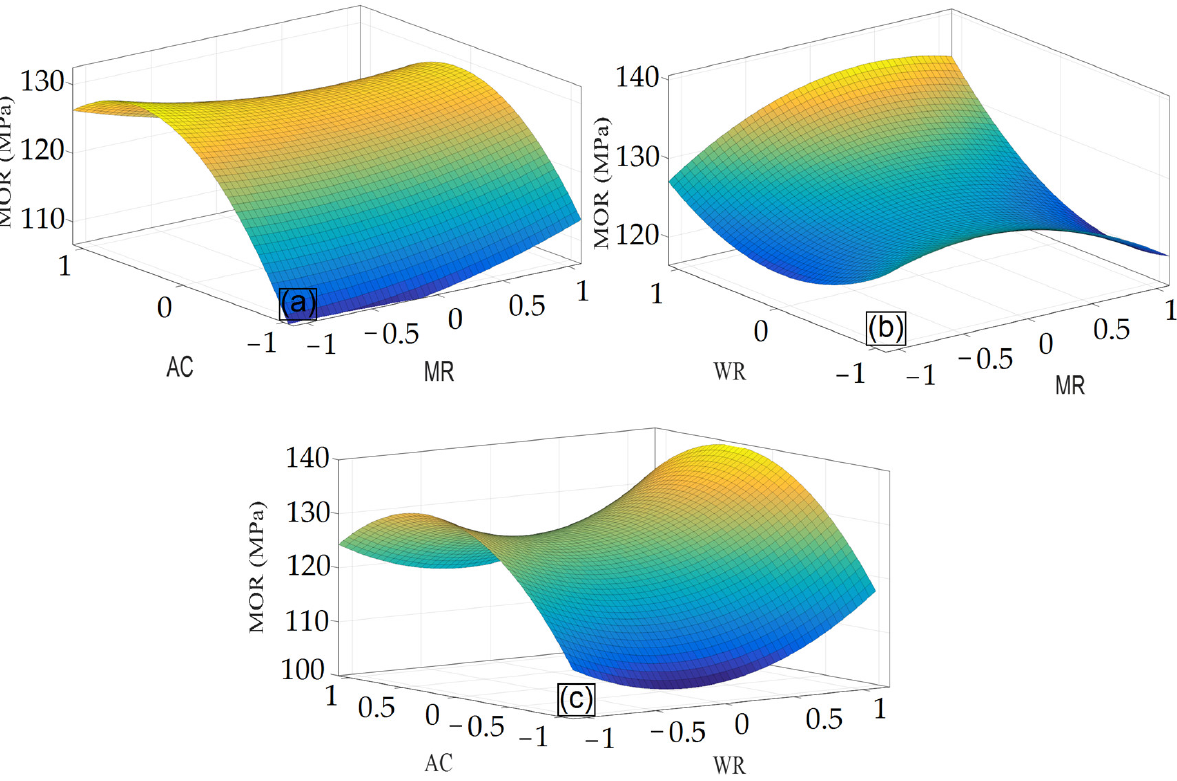
Figure 8. The interactive effect of ( a ) MR×WR, ( b ) MR×AC, and ( c ) WR×AC on the bending strength.